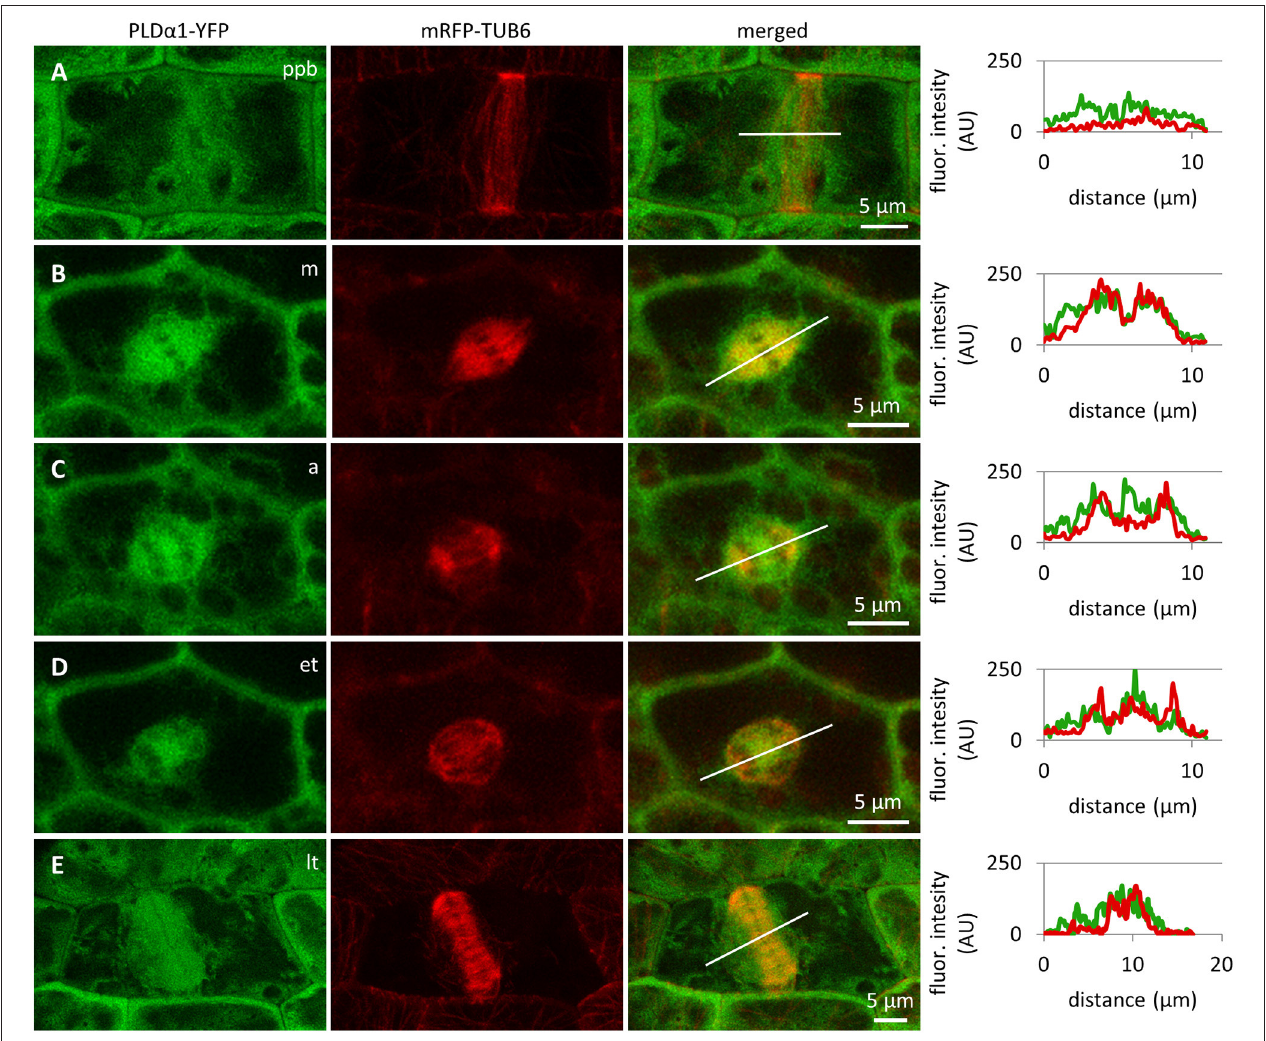
FIGURE 8 | Subcellular localization of PLD α 1-YFP during cell division. Live cell imaging of PLD α 1-YFP (green) and mRFP-TUB6 (red) in dividing leaf petiole epidermal cell of the pld α 1-2 mutant plants stably expressing PLD α 1-YFP driven by PLD α 1 own promoter. PLD α 1-YFP was enriched at the location of preprophase band of microtubules (PPB) (A) , while it strongly associated with the mitotic spindle (B–D) , early (D), and late (E) phragmoplast. Profiles of fluorescent intensity of YFP and mRFP distribution measured at individual cell division stages are indicated by lines (A–E) . ppb, preprophase band of microtubules; m, metaphase; a, anaphase; et, early telophase; lt, late